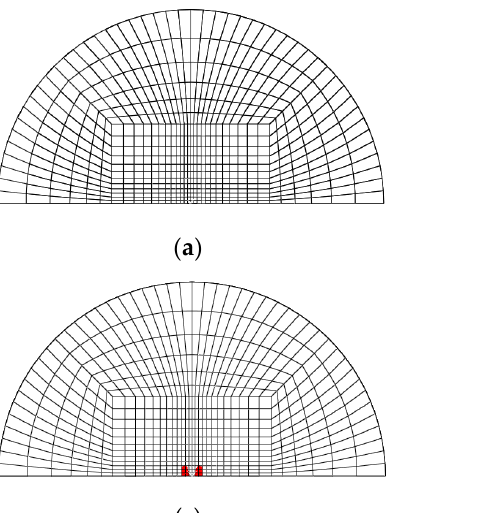
Figure 21. Fiber tension failure (FTF) in the composite layers of GLARE 5-2/1 with [0 ° /90 ° /90 ° /0 ° ] after applying the second impact energy of 8 J; ( a ) 2D failure model (0.392 ms), ( b ) 2D failure model (2.22 ms), ( c ) 3D failure model (0.392 ms), ( d ) 3D failure model (1.96 ms).